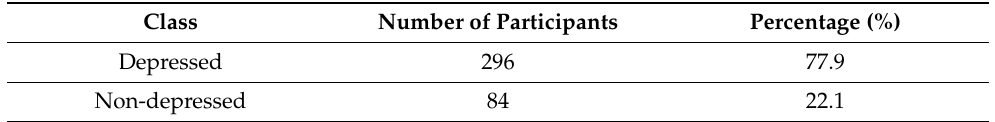
Table 1. Distribution of depressed and non-depressed dataset